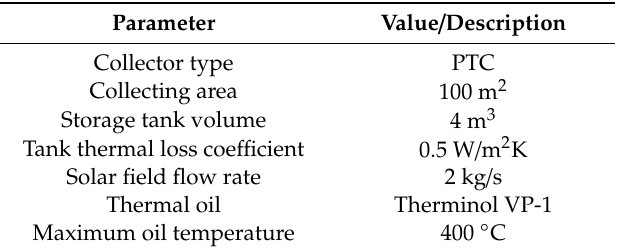
Table 1. Data of the solar field / storage